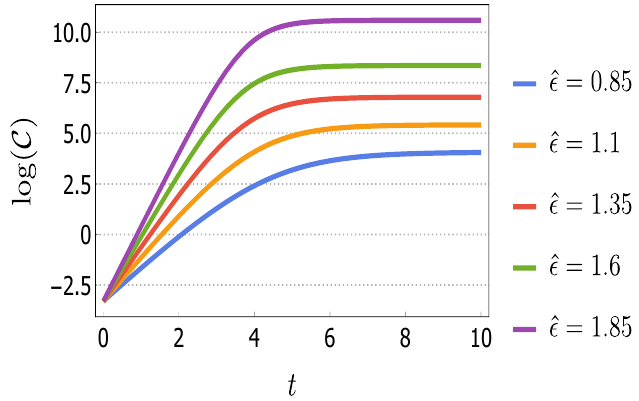
Figure 2 . Evolution of logarithm of Complexity for a K = 2 parameter system with a variation of eigenvalue of Encoder-Dataset tensor A ∞ .